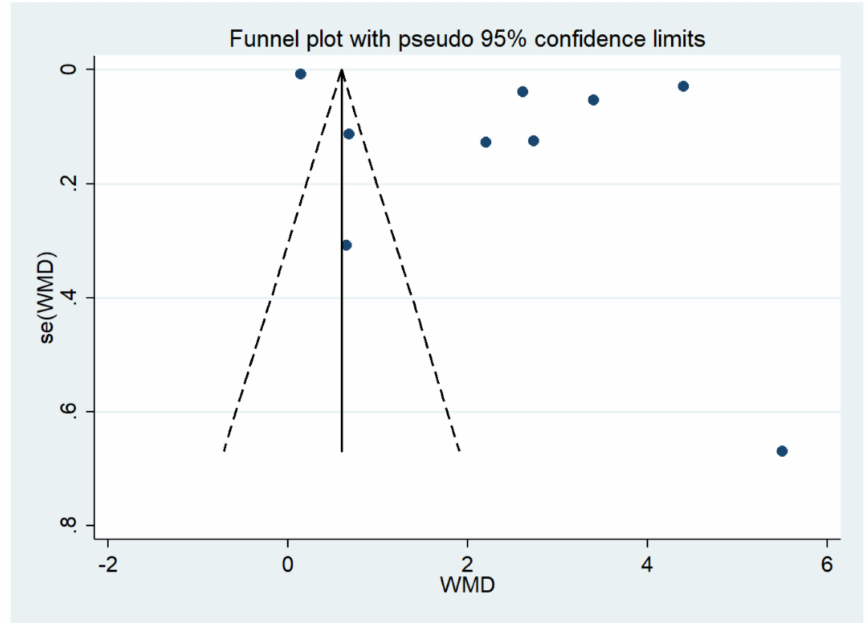
Figure 13. The funnel plot demonstrated an asymmetrical distribution of the estimates (blue dot) from the middle line. Abbreviations: se, standard error; WMD, weighted mean difference.